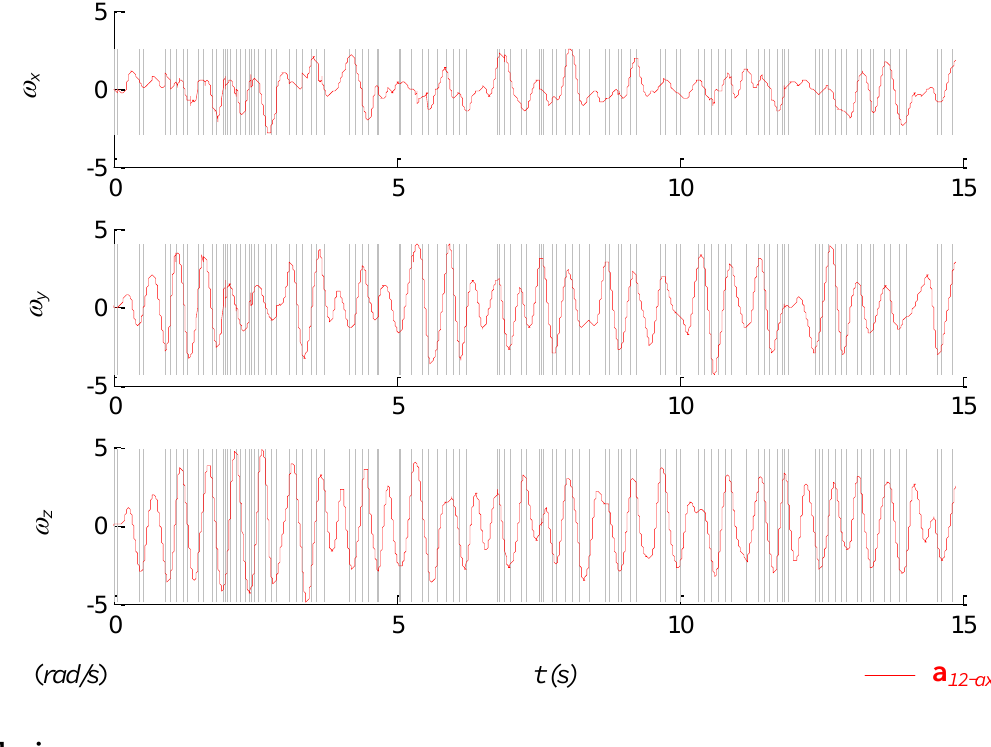
Figure 12. The timing of switching (grey lines) between the integration method and the quadratic